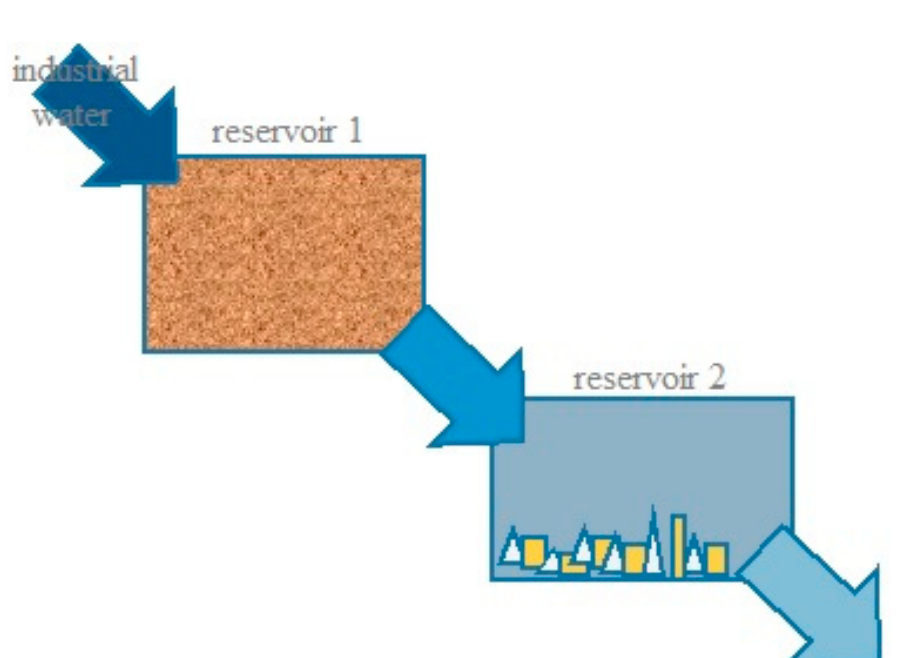
Figure 6. Scheme of thermodynamic modeling of the interaction of dam rocks with industrial water.